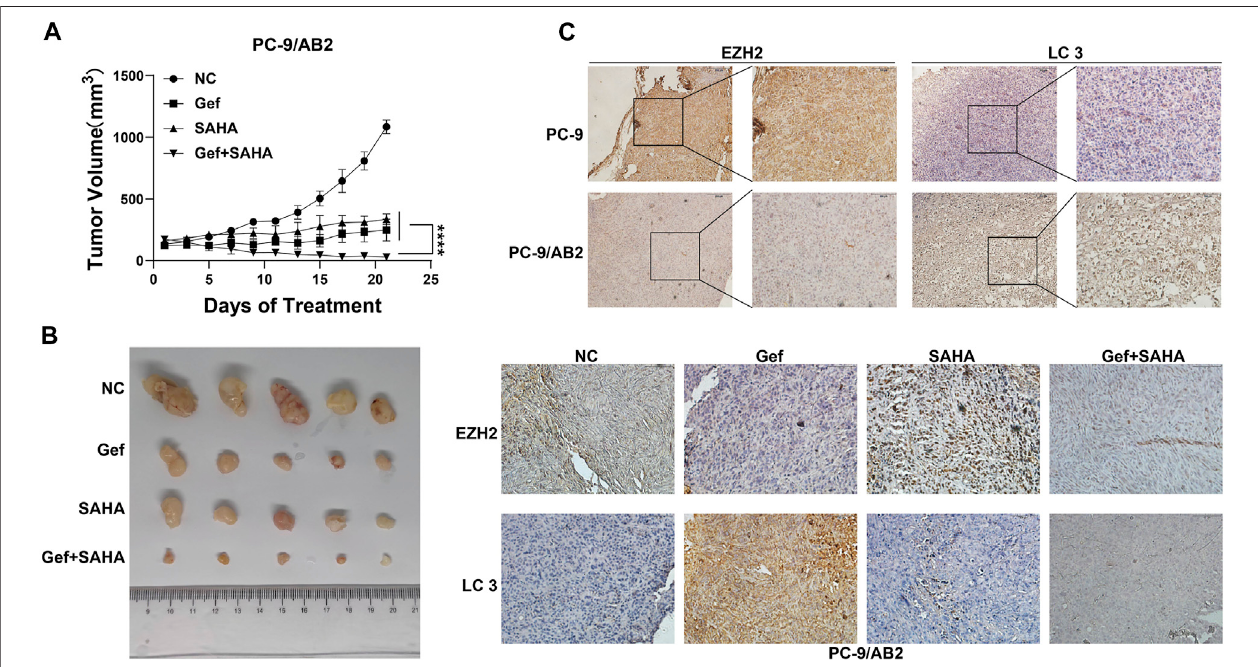
FIGURE5 | SAHA enhanced the antitumor effect ofEGFR-TKIs in vivo . (A – B) Nude mice with tumors ofPC-9/AB2 cells received ge fi tinib (50 mg/kg orally), SAHA (50 mg/kg orally), and a Gef + SAHA combination after 3 weeks of treatment every other day. Results are presented as mean ± standard deviation. **** p < 0.0001. (C) Immunohistochemistry was performed to detect EZH2 and LC3 in tumor sections of nude mice.